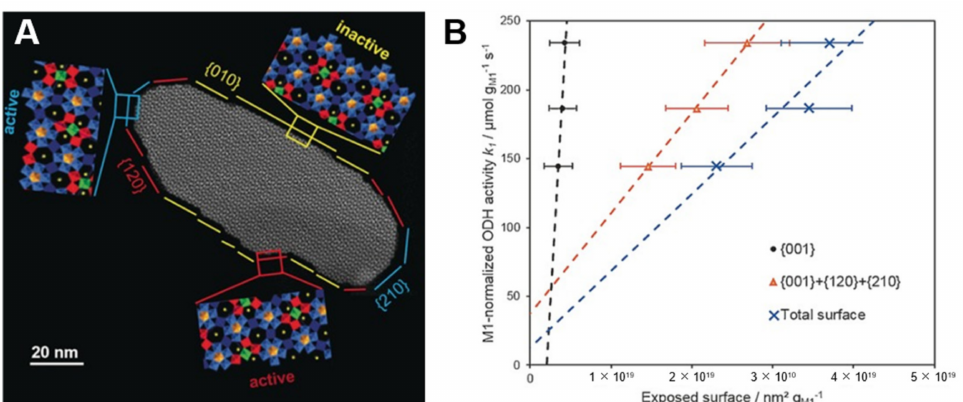
Figure 9. ( A ) Unprocessed STEM image showing crystalline lateral termination facets of a typical flattened M1 particle viewed along [001] direction. ( B ) Comparison of activity for basal plane (001) with the combination of active facets and with the total surface area. Adapted from ref. [16], Copyright (2016), with permission from John Wiley &